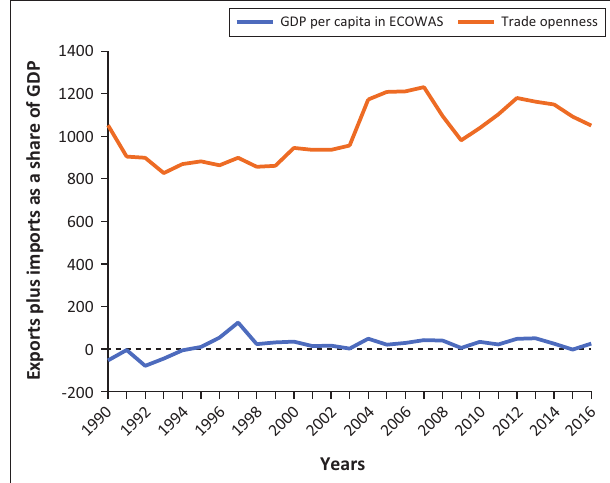
FIGURE 1: Gross domestic product (GDP) per capita and trade openness across the 15 Economic Community of Western African States countries,